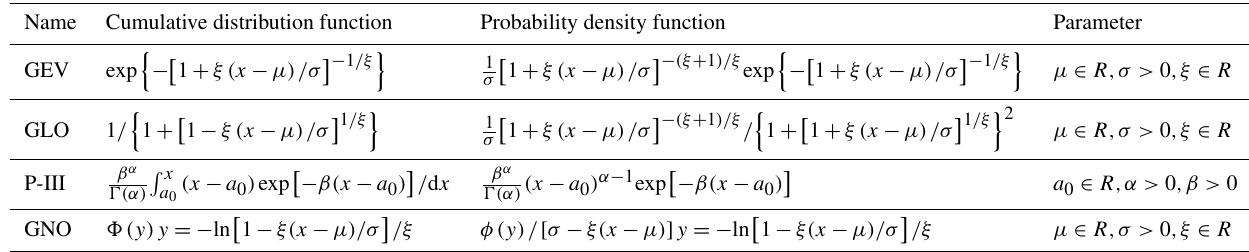
Table 1. Theoretical cumulative distribution and probability density function of three parameter univariate distribution.